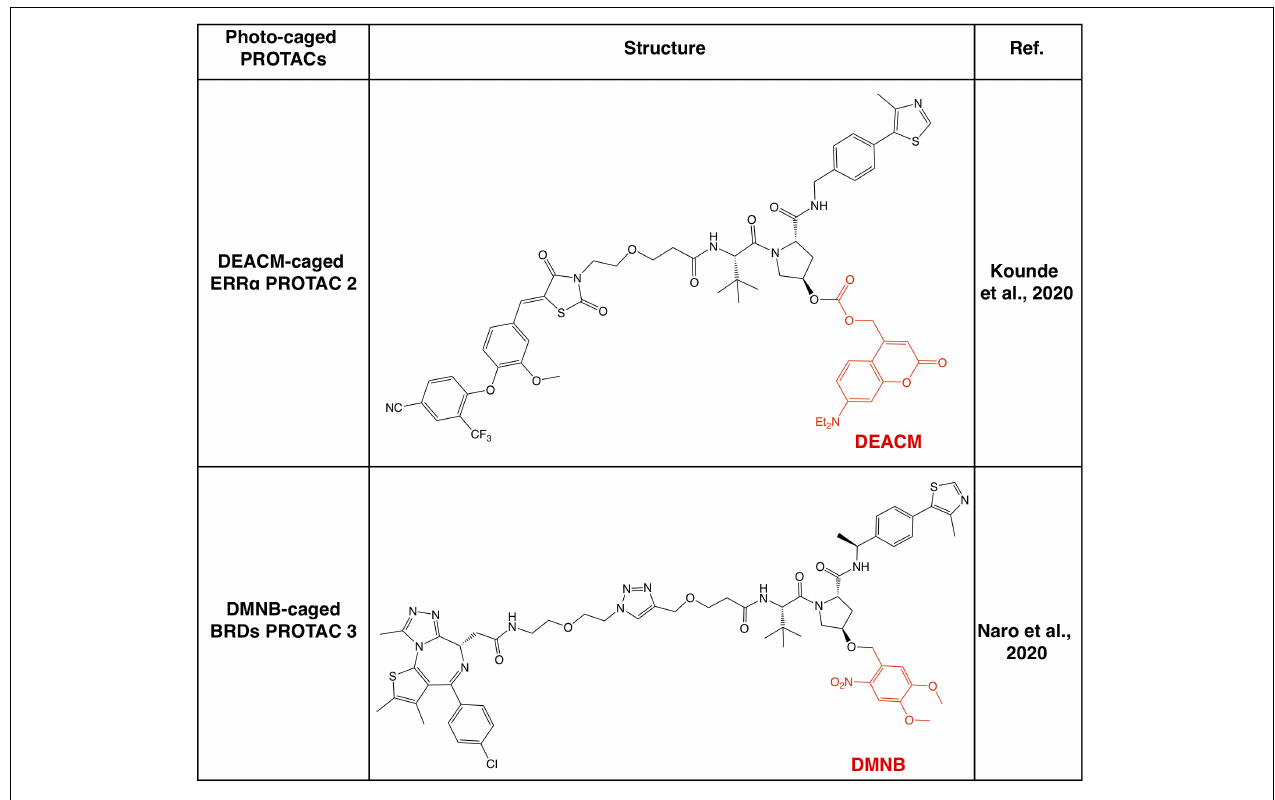
FIGURE 4 | Summary of photo-caged VHL-based PROTACs. Photo-cage groups are marked in red. The photo-cage groups are in red. DMNB, 4,5-dimethoxy-2-nitrobenzyl; DEACM, diethylamino coumarin.